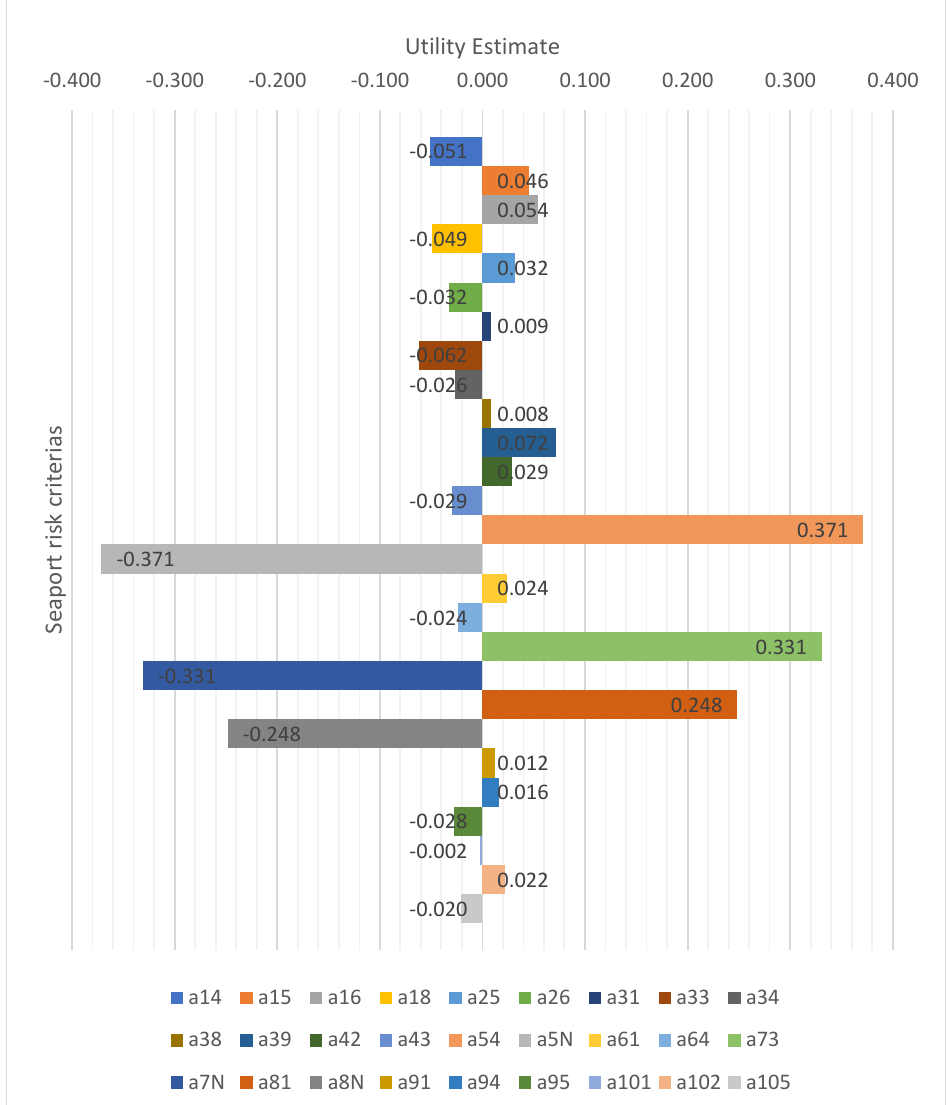
Figure 3. Conditional seaport risks ratio.